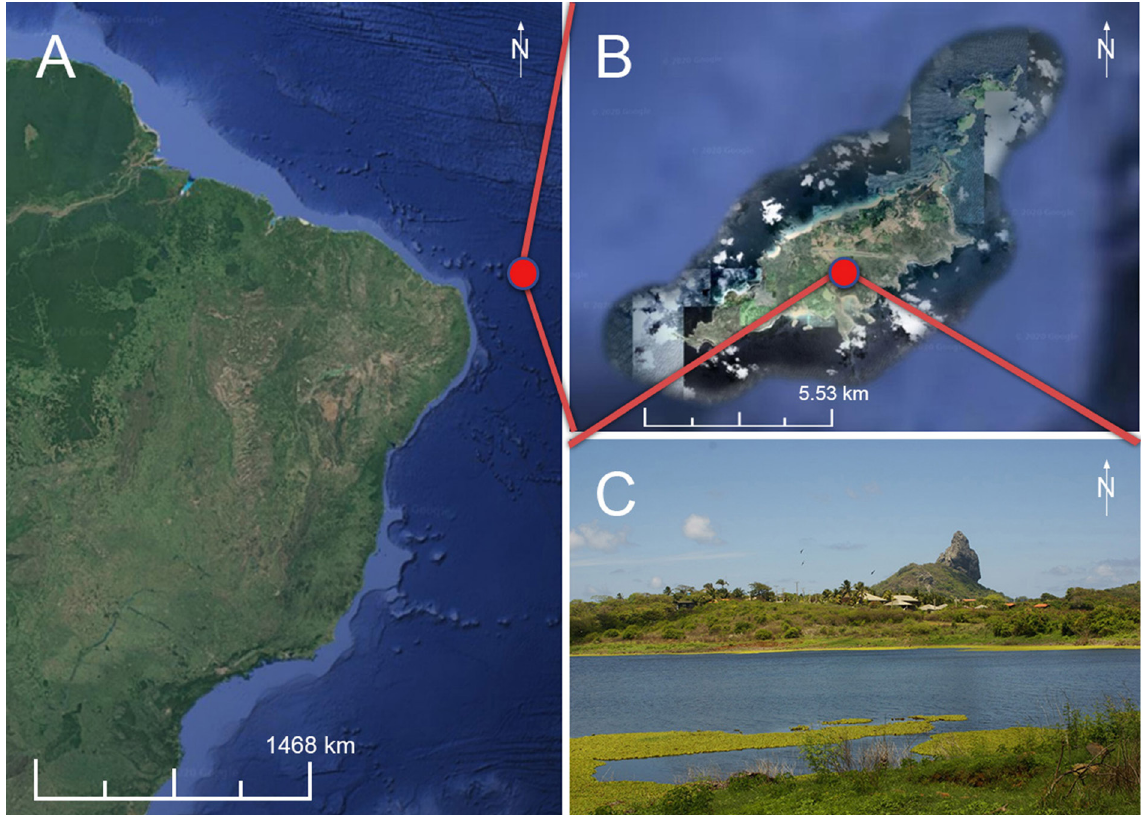
Fig. 1. Sampling location, at the state of Pernambuco, Fernando de Noronha archipelago, Brazil A . Brazil. B . Fernando de Noronha Archipelago. C . Xaréu açude. Images provided by Google Earth (A–B) and Prof Dr Felipe Toledo, University of Campinas